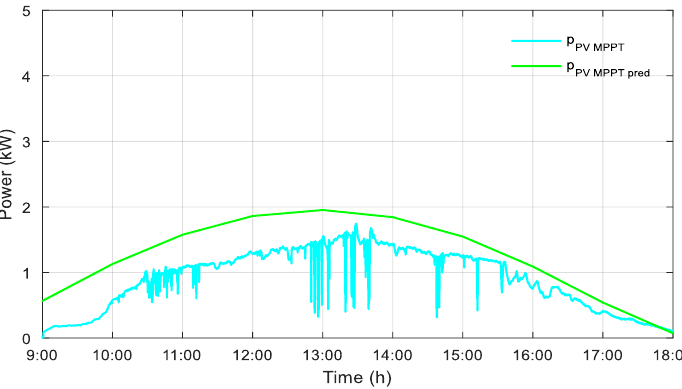
Figure 23. PV MPPT real and predicted powers and IIREV demand power—experimental test 2.